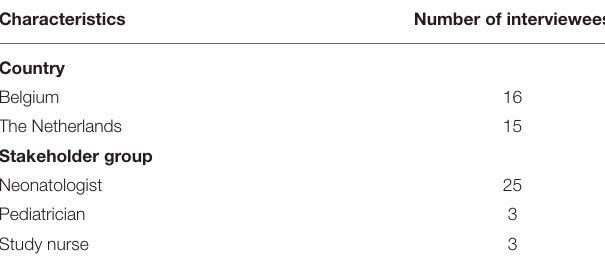
TABLE 1 | Descriptive characteristics of the